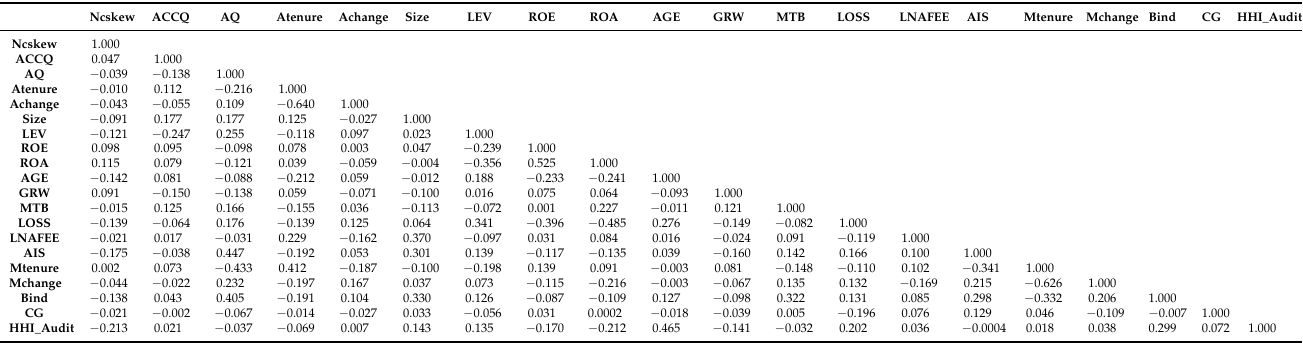
Table 5. The correlation coefficients of the variables (Pearson method).